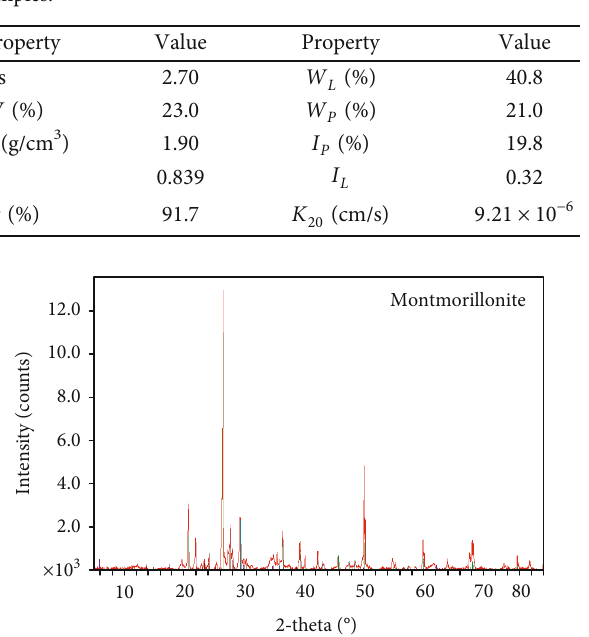
Figure 3: XRD patterns of the representative soil samples.